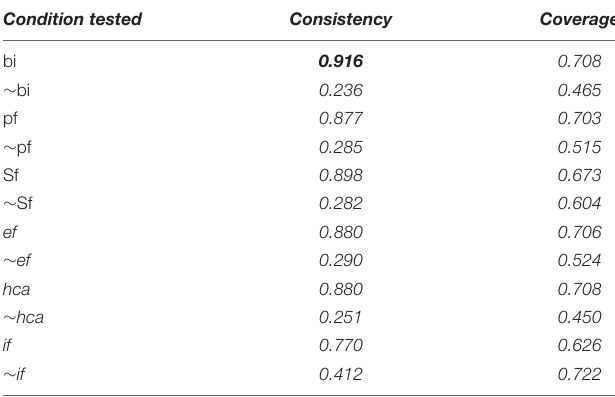
TABLE 8 | Necessity